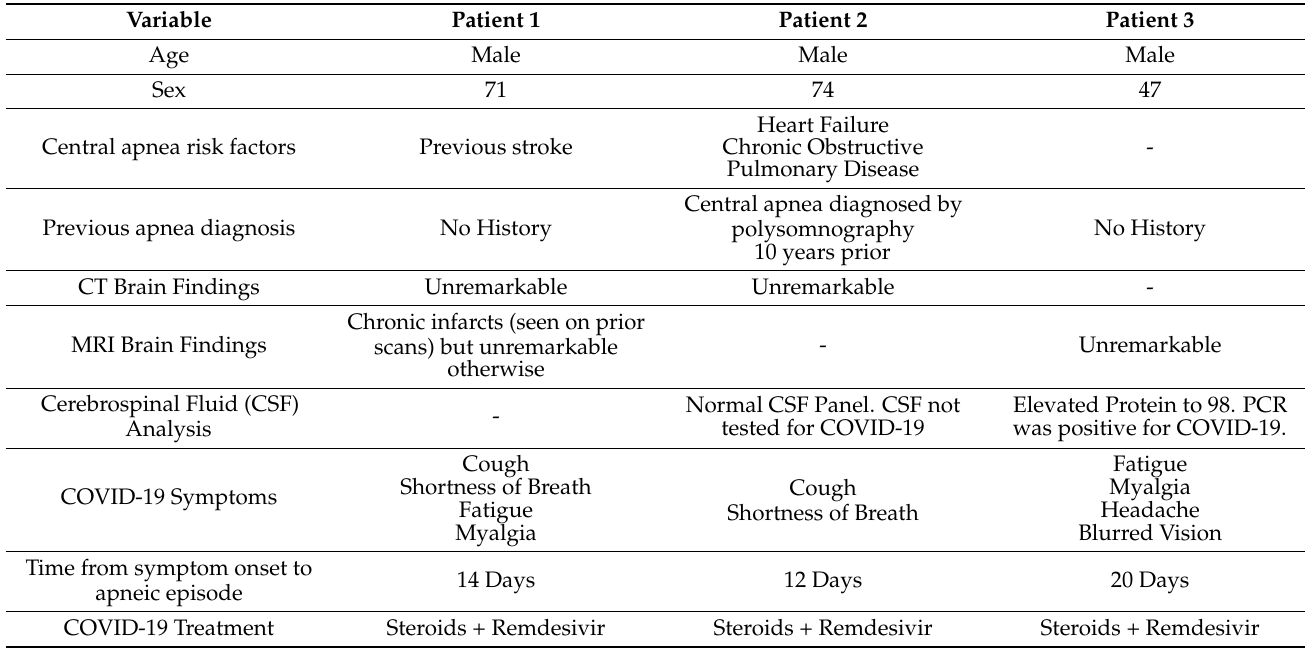
Table 1. Key patient characteristics, diagnostic evaluations, and hospital course for included